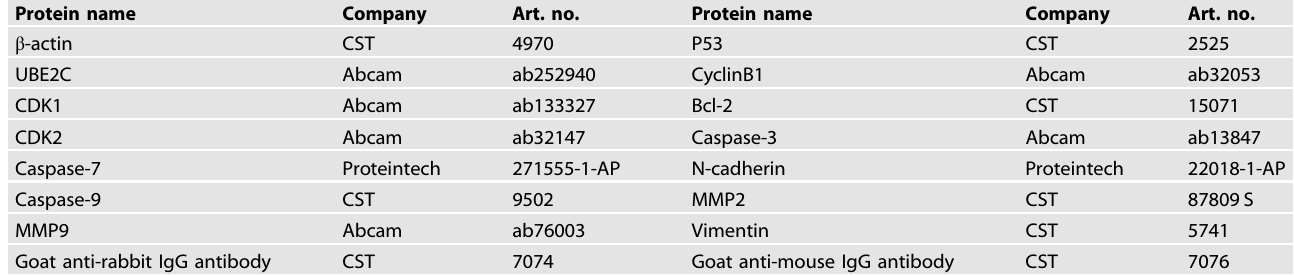
Table 5. List of antibodies